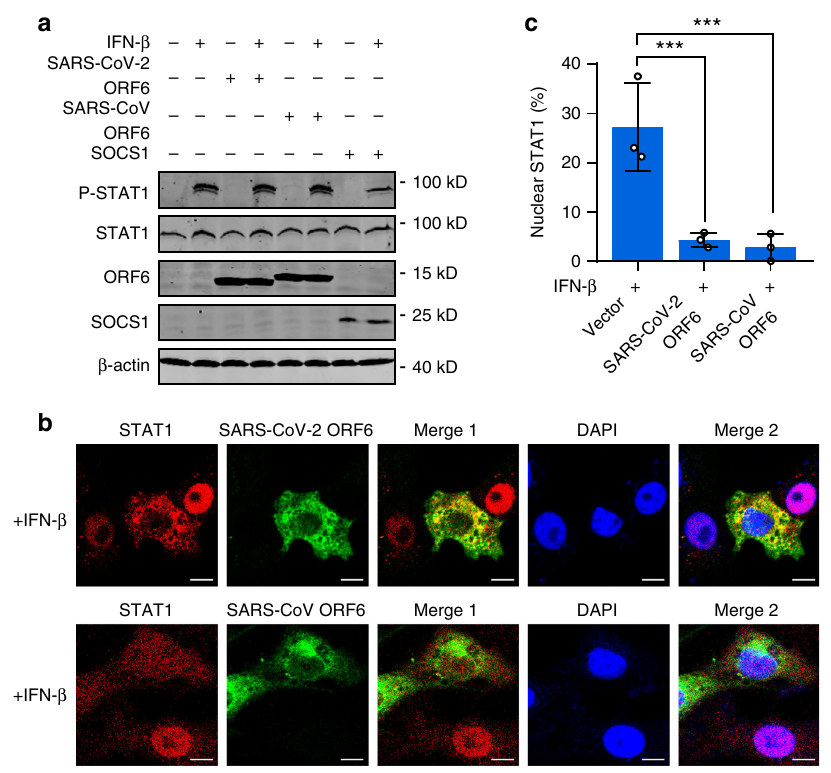
Fig. 6 ORF6 inhibits STAT1 nuclear translocation but not phosphorylation. a Effect of SARS-CoV ORF6 and SARS-CoV-2 ORF6 on IFN- β -induced phosphorylation of STAT1. HEK293T cells were transfected with a control plasmid or with plasmids expressing SARS-CoV ORF6, SARS-CoV-2 ORF6, or SOCS1. At 24 h after transfection, cells were left untreated or treated with 1000 U/ml IFN- β for 30 min. The phosphorylation of STAT1 was detected by Western blot analyses. b Effect of SARS-CoV ORF6 and SARS-CoV-2 ORF6 on IFN- β -induced nuclear translocation of STAT1. Vero cells were transfected with plasmids expressing SARS-CoV ORF6 and SARS-CoV-2 ORF6. At 24 h after transfection, cells were treated with 1000 U/ml IFN- β for 30 min and stained with indicated antibodies. Merge 1 and Merge 2 indicate the merged red and green channels and the merged red, green, and blue channels, respectively. Scale bar, 10 μ m. c Quantitation of the nuclear translocation of STAT1. All experiments were done at least twice, and one representative is shown. Error bars indicate SD of technical triplicates. *** P < 0.001, two-tailed Student ’ s t -test. Source data are provided as a Source Data fi